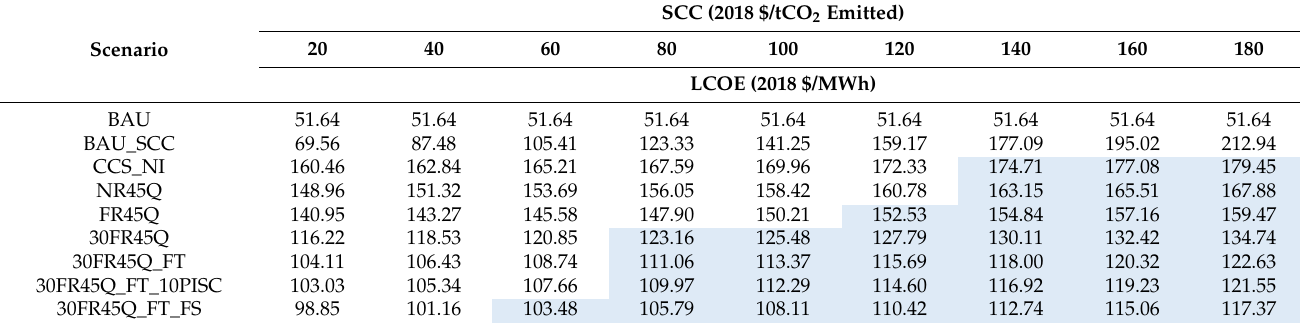
per-unit tax range. When the LCOE for a given SCC and policy scenario pairing (for scenarios 3–9) is less than its Scenario 2 LCOE for that SCC, its finance gap (the difference between the LCOEs, shown in Tables A8 and A9) is negative, and deployment of CCS is the cheaper option (highlighted in light blue in Tables A6–A9). Table A6. LCOE (2018$/MWh) for 650-MW SubC PC scenarios.